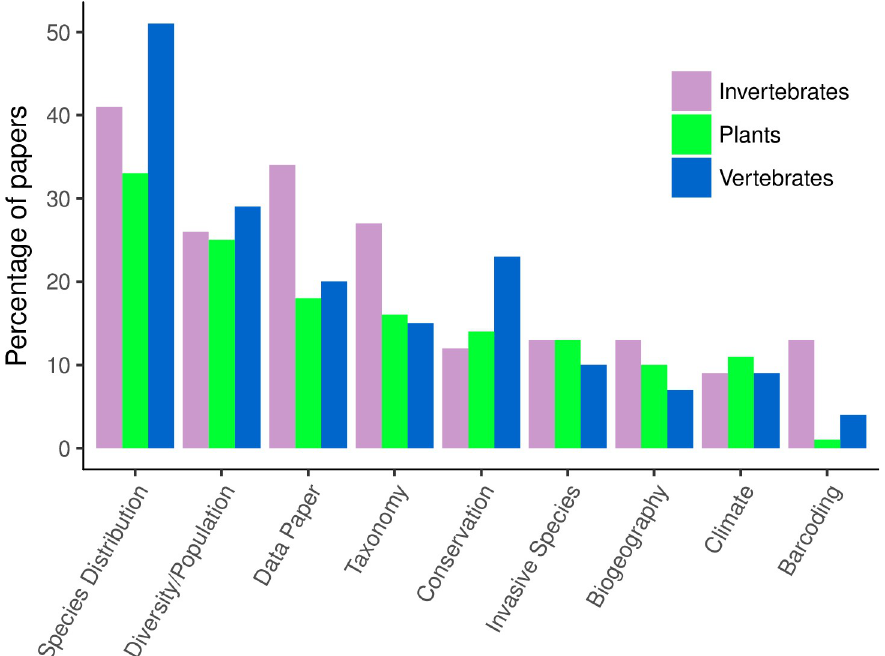
Fig 4. Percentage of papers involving each of the major taxonomic groups (invertebrates, plants, and vertebrates) that use species occurrence databases for certain research applications: Species distribution, diversity/population, data paper, taxonomy, invasive species, biogeography, climate change, and